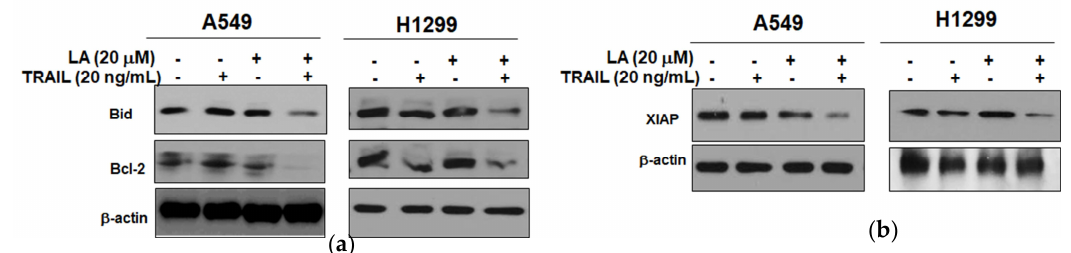
Figure 3. Combined effect of LA and TRAIL on antiapoptotic and proapoptotic proteins in A549 and H1299 non-small cell lung cancer cells. ( a , b ) Cells were treated with LA (20 μM) and/or TRAIL (20 ng/mL) for 24 h. Cell lysates were prepared and subjected to Western blotting for Bid, Bcl-2, and XIAP. 2.4. Combined Treatment of LA and TRAIL Upregulated the Expression of DR4 and Inhibited the Expression of p-NF-κB, p-IκB, and FLIP in A549 and H1299 Non-Small Cell Lung Cancer Cells